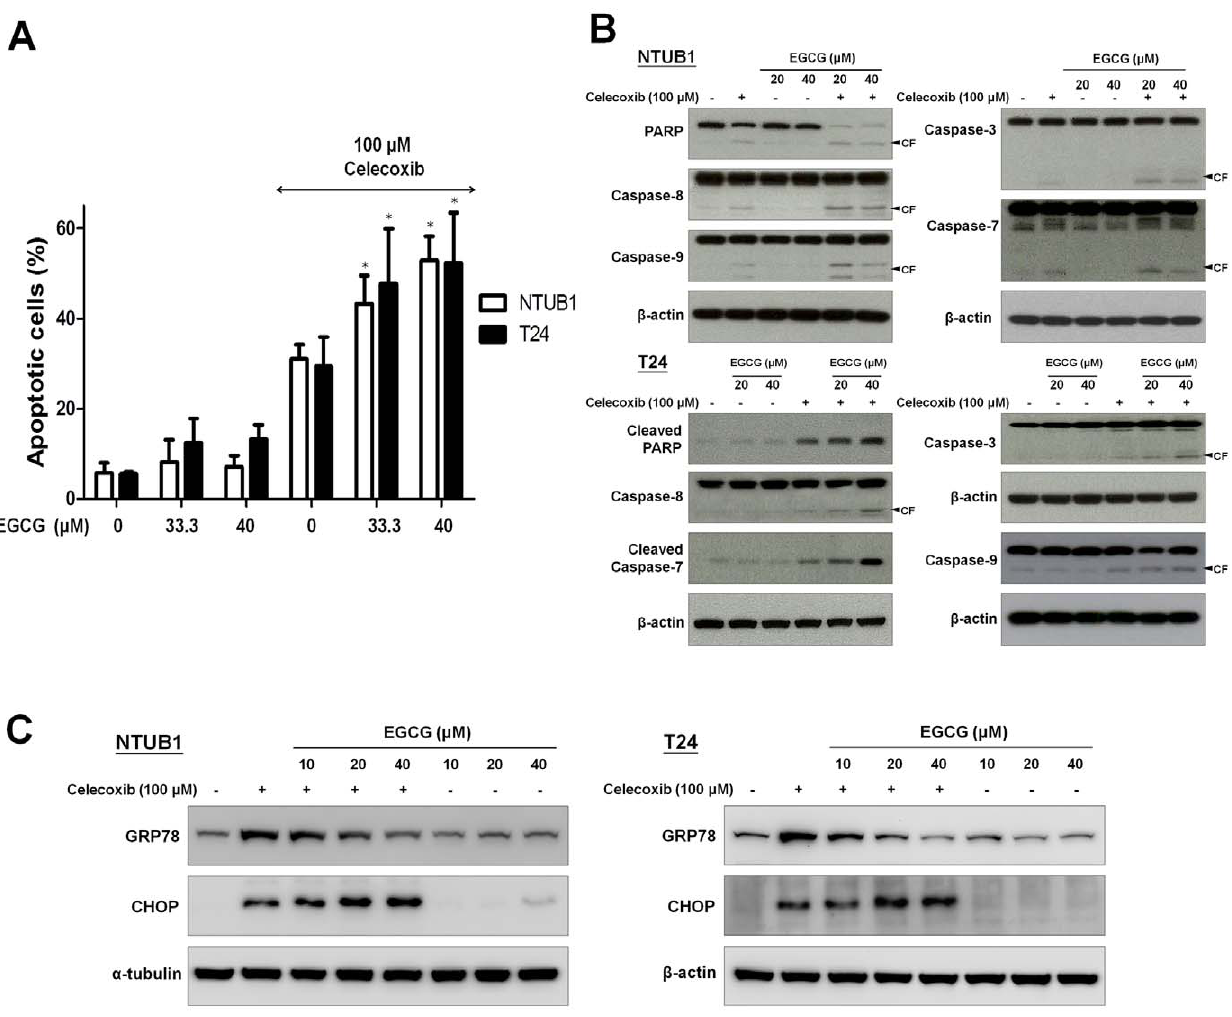
Figure 5. The combinative effects of celecoxib and EGCG on apoptosis in NTUB1 and T24 cells. Cells were incubated in the presence of 100 m M celecoxib and EGCG (10, 20, 33.3 and 40 m M) individually or in combination. (A) Cells were stained with annexin V-FITC and PI for apoptosis analysis by FACS flow cytometry. Results shown are representative of at least three independent experiments. Data are presented as means 6 SD of three independents experiments. * p , 0.05 as compared with celecoxib alone. (B) and (C) Cell lysates were harvested and analyzed by Western blotting with specific antibodies against caspase-3, 7, 8, 9, PARP, GRP78, and CHOP. CF is the abbreviation of cleaved form. Results shown are representative of at least three independent